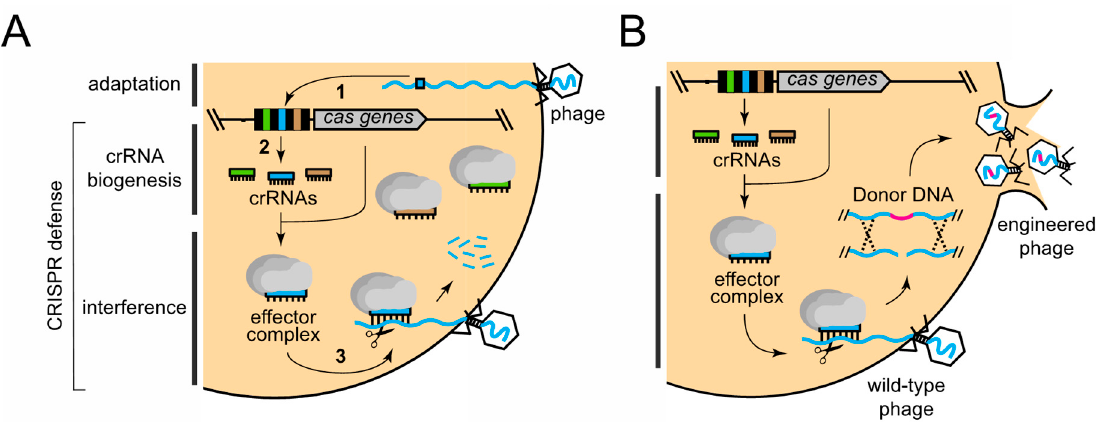
Figure 1. The CRISPR–Cas pathway and its application to phage genome editing. ( A ) The general three-step mechanism of CRISPR–Cas immunity consists of (1) adaptation; (2) crRNA biogenesis; and (3) interference. The latter two steps constitute CRISPR defense. Within the CRISPR locus, DNA repeats (black rectangles), spacers (colored rectangles), and cas genes (grey arrow) are shown. ( B ) The approach to using CRISPR defense for phage editing, wherein defense is used as a counter-selection mechanism to enrich for recombinant phages that have acquired mutations in the desired gene(s) from a donor DNA construct.